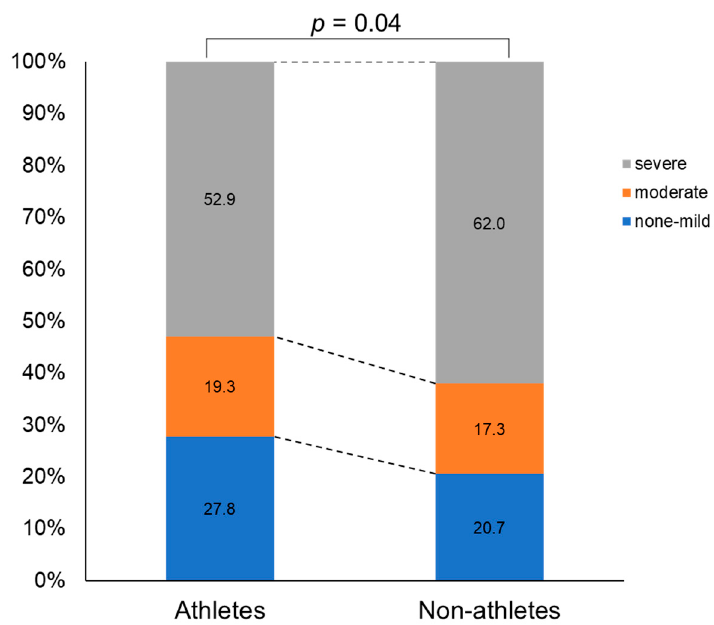
Figure 2. Severity of dysmenorrhea in athletes and non-athletes. Table 2. Characteristics by severity of dysmenorrhea in athletes.